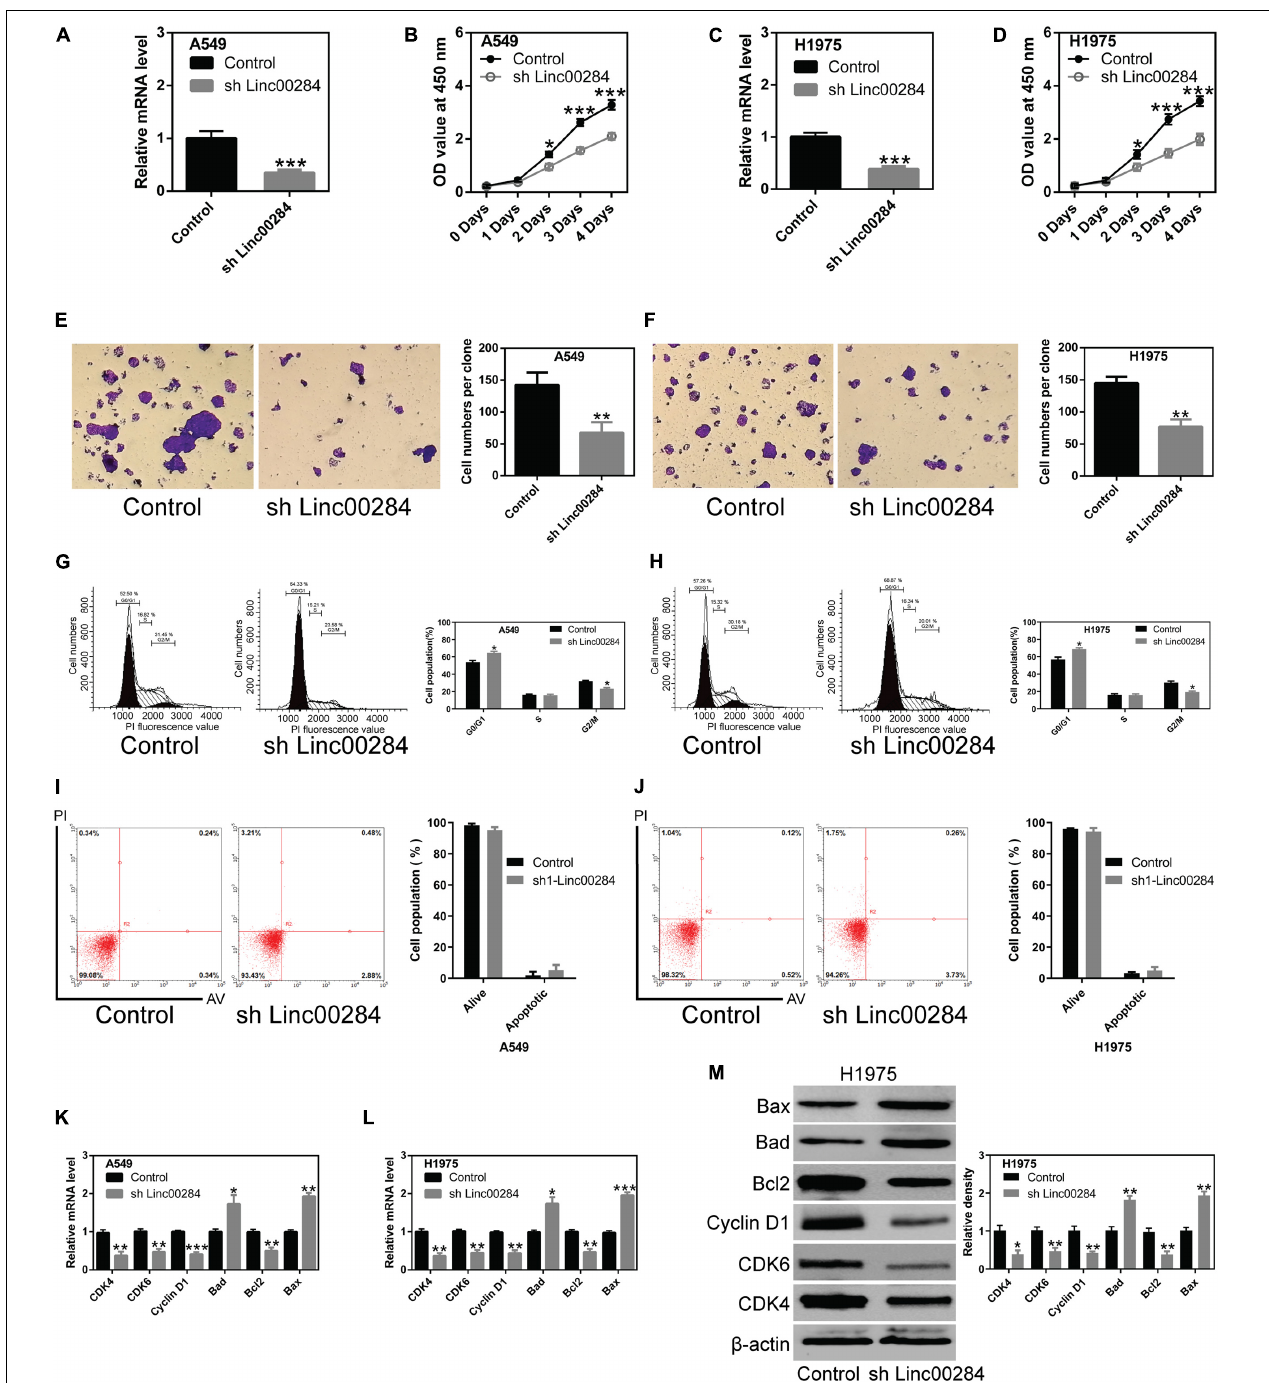
FIGURE 2 | Linc00284 silencing inhibits lung cancer cell proliferation. (A) Knockdown efficiency was measured by RT-qPCR in A549 human lung cancer cells. (B) The proliferative capacity of A549 cells with Linc00284 silencing was determined by CCK-8 assay. (C) Knockdown efficiency was measured by RT-qPCR in H1975 human lung cancer cells. (D) Proliferation of Linc00284-silenced H1975 cells was measured by CCK-8 assay. (E,F) Representative images and statistical analysis results of the colony-forming ability of Linc00284-silenced (E) A549 and (F) H1975 cells, as determined by colony formation assay. Magnification, × 10. (G,H) Representative images and quantification of cell cycle distribution of Linc00284-silenced (G) A549 and (H) H1975 cells, as determined by flow cytometry. (I,J) Apoptosis of (I) A549 and (J) H1975 cells in which Linc00284 was knockdown, measured using flow cytometry. (K,L) mRNA levels of apoptosis- or cell cycle-related genes in Linc00284-silenced (K) A549 and (L) H1975 cells, as evaluated by RT-qPCR. (M) Apoptosis- or cell cycle-related protein expression in H1975 cells in which Linc00284 was knocked down, determined by western blotting. Data were analyzed using unpaired t -test. Error bar represents standard deviation (SD) for triplicate independent experiments. * P < 0.05, ** P < 0.01, and *** P < 0.001, compared with matched control cells.